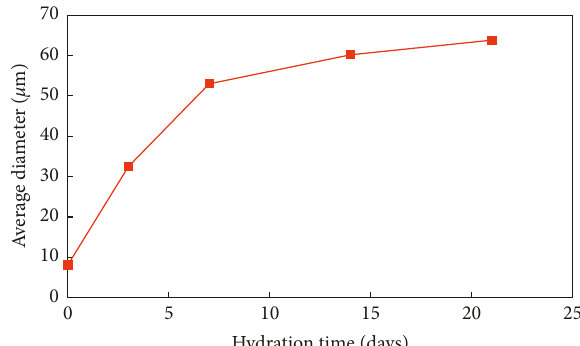
Figure 6: Average diameters of core-shell microspheres versus hydration time.